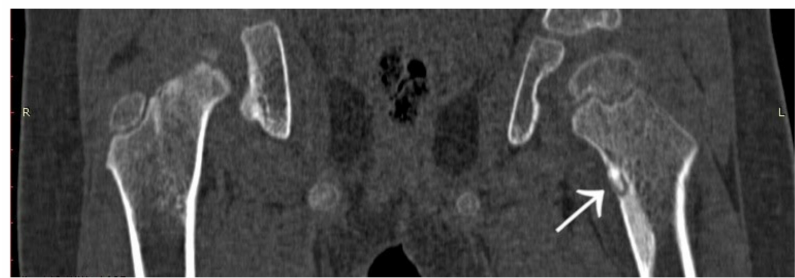
Figure 7. CT scan of the hip joints showing a focus of OO (arrow).